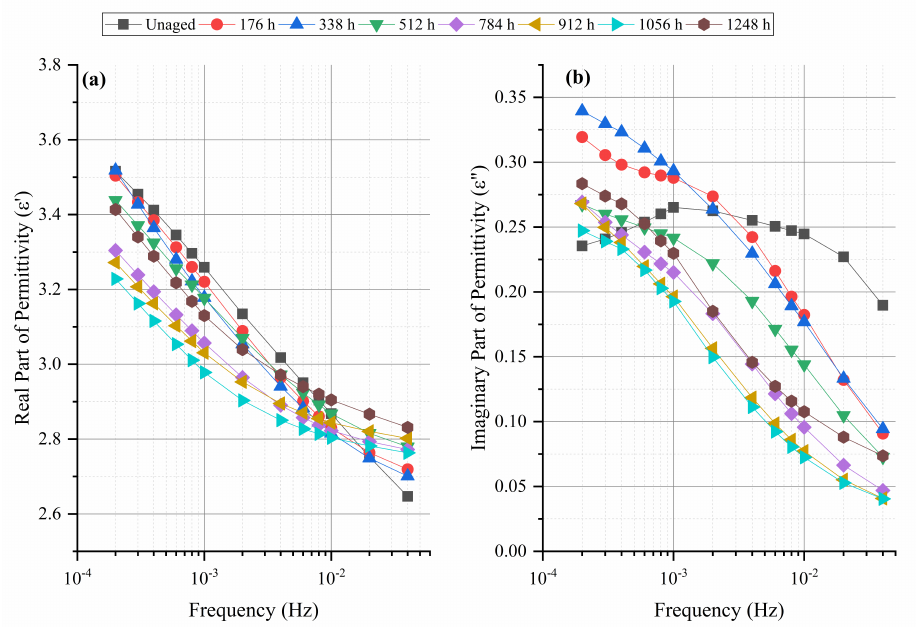
Figure 5. ( a ) Real and ( b ) imaginary parts of permittivities for thermal